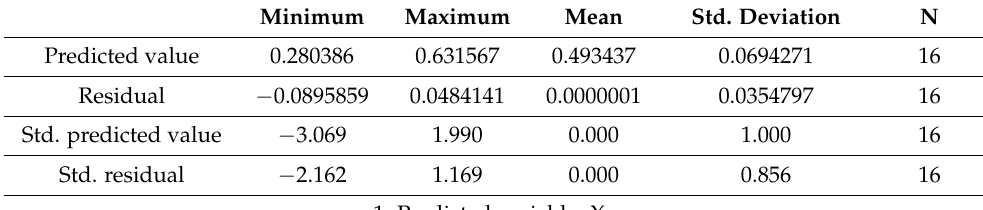
Table 18. Statistics of residuals for 2nd order polynomial with two predictors.